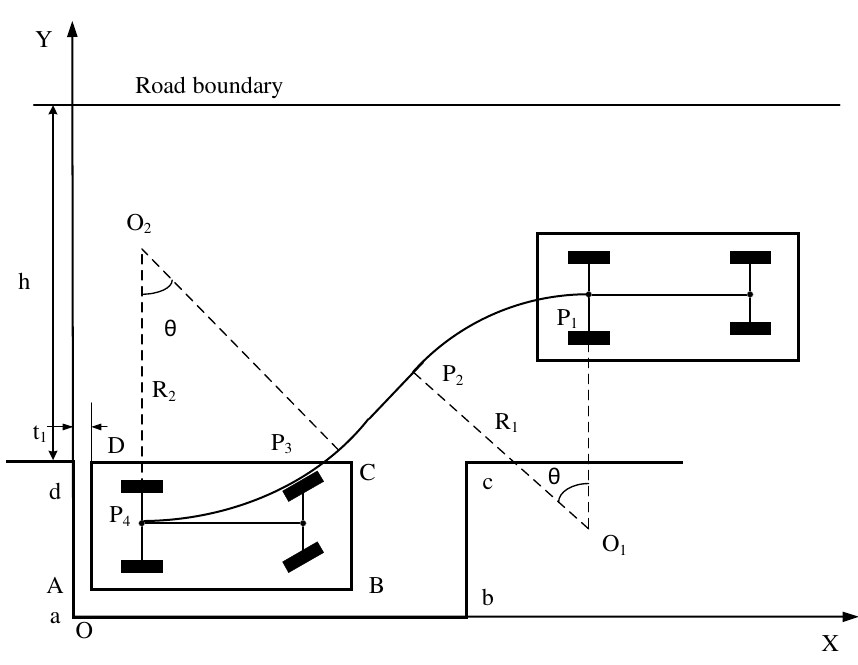
Figure 3. Parallel parking start area analysis.